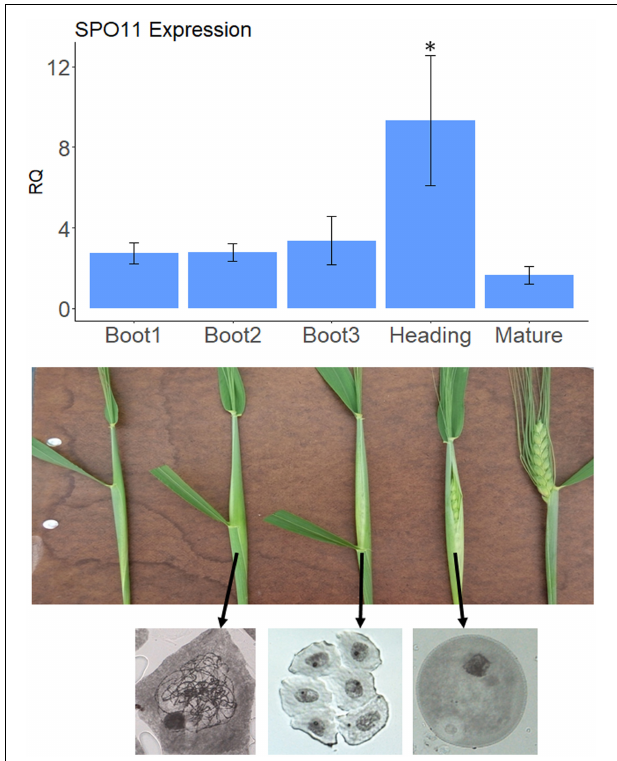
FIGURE 1 | SPO11 expression at different developmental stages. The upper panel shows relative expression levels of SPO11 as determined by qPCR, during five developmental stages of the spike, shown in the bottom panel for cv. Svevo. The reference gene was Actin . Bars represent SE, the number of replica, N = 3, Asterisk designate significant differences from the Mature stage ( p < 0.05). The bottom panel shows meiotic stage analysis by Acetocarmine staining of male meiocytes taken from the middle spikeletes at different physiological stages. Arrows show origin of stained meiocyes. Left, zygotene; Middle, tetrad; Right, young